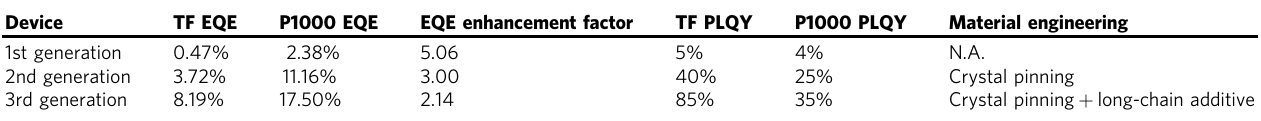
Table 3 Device peak external quantum ef fi ciency (EQE) and photoluminescence quantum ef fi ciency (PLQY) of our three generations devices during the course of material optimization Device